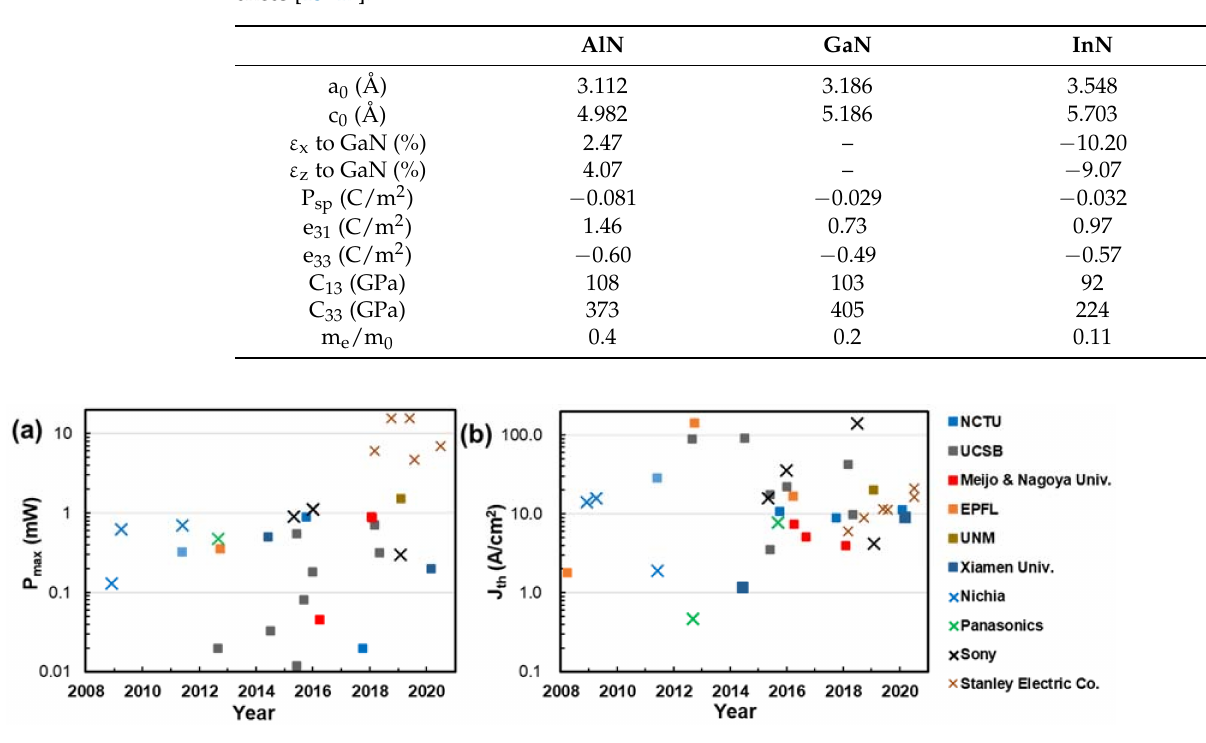
Figure 2. Benchmarks of ( a ) maximum output power (P max ) and ( b ) threshold current density (J th ) of electrically pumped nitride blue VCSELs in chronological order of publication. Device parameters were extracted from references